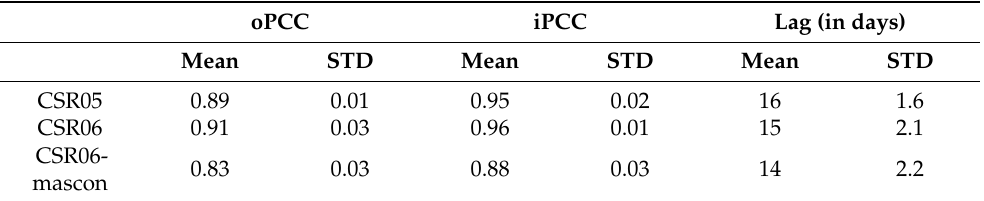
Figure 6. The original Pearson correlation coefficient (PCC) (solid line) and improved PCC (dotted line) between the runoff and ( a ) CSR05, ( b ) CSR06, and ( c ) CSR06-mascon EWHs via the three-year rolling window using the C-method. The gray bar represents the corresponding time lag. The x-axis labels complete three-year periods. For example, “2005–2007” represents the time period between January 2005 and December 2007. Table 2. The mean values and STDs of the original PCC (oPCC), the improved PCC (iPCC), and the lag between runoff and the three